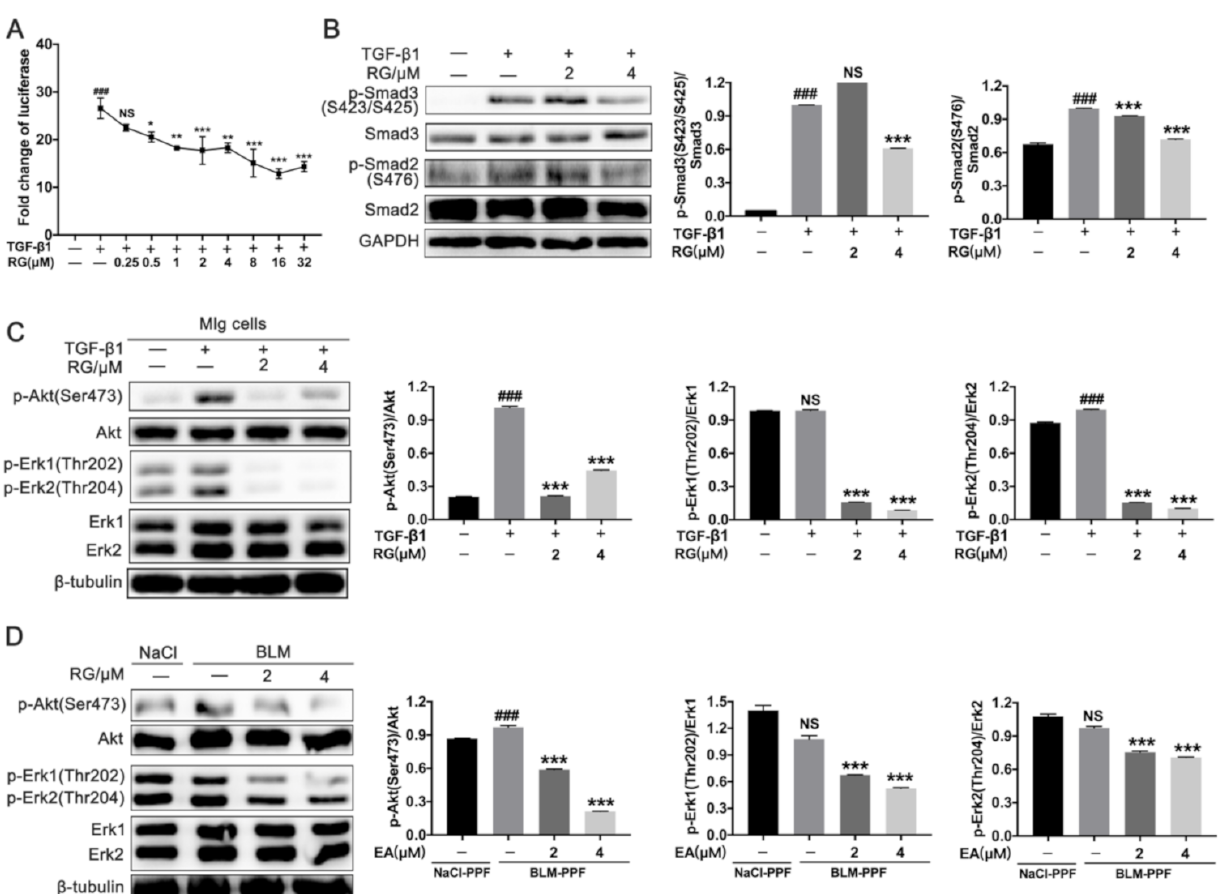
Figure 3. Regorafenib down-regulates TGF- β 1/Smad and TGF- β 1/non-Smad signals in pulmonary fibroblasts. ( A ) CAGA- mouse embryonic fibroblast (NIH-3T3) cells were exposed to TGF- β 1 (5 ng/mL) or a series concentration (0–32 µ M) in serum-free medium for 18 h; ( B ) Mlg cells were treated with TGF- β 1 (5 ng/mL) and/or RG (2 µ M, 4 µ M) for 30 min, and Western blot was used to detect Smad3, Smad2, and their phosphorylation expression levels. Densitometric analysis are shown beside; ( C ) Mlg cells were incubated with RG (2 µ M, 4 µ M) and/or TGF- β 1 (5 ng/mL) for 12 h to analyze the Erk1/2 and Akt and their phosphorylation levels by Western blotting. Densitometric analysis are shown beside; ( D ) BLM-PPF cells were incubated with RG (2 µ M, 4 µ M) for 12 h to analyze Erk1/2 and Akt and their phosphorylation levels by Western blotting. Densitometric analysis are shown beside. β -tubulin or GAPDH were used as a loading control. Data in ( A – D ) are means ± standard error of mean (SEM); ### p < 0.001, * p < 0.05, ** p < 0.01, *** p < 0.001 (one-way ANOVA), NS: not